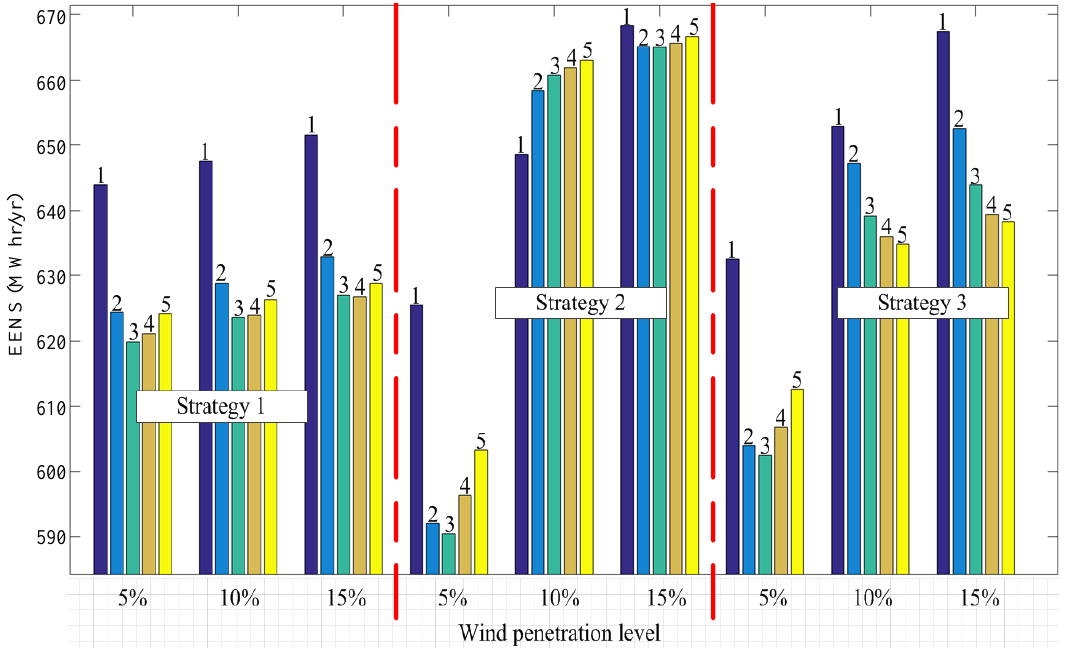
Figure 3. Effects of the BESS charging rate (DR 70% load curve).